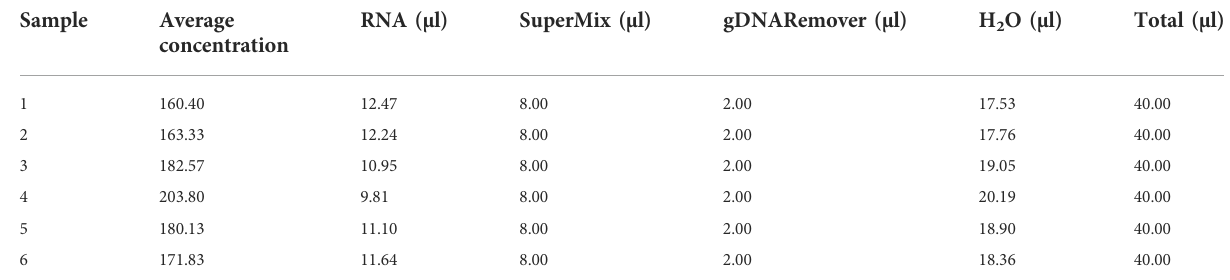
TABLE 2 Example of CalRTable output.